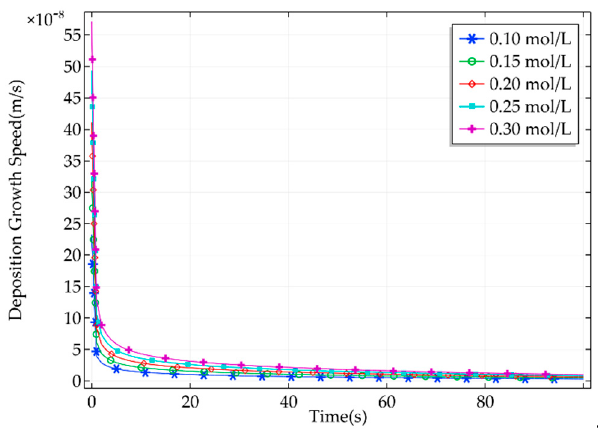
Figure 6. Deposition growth speed corresponding to different electrolyte concentrations.